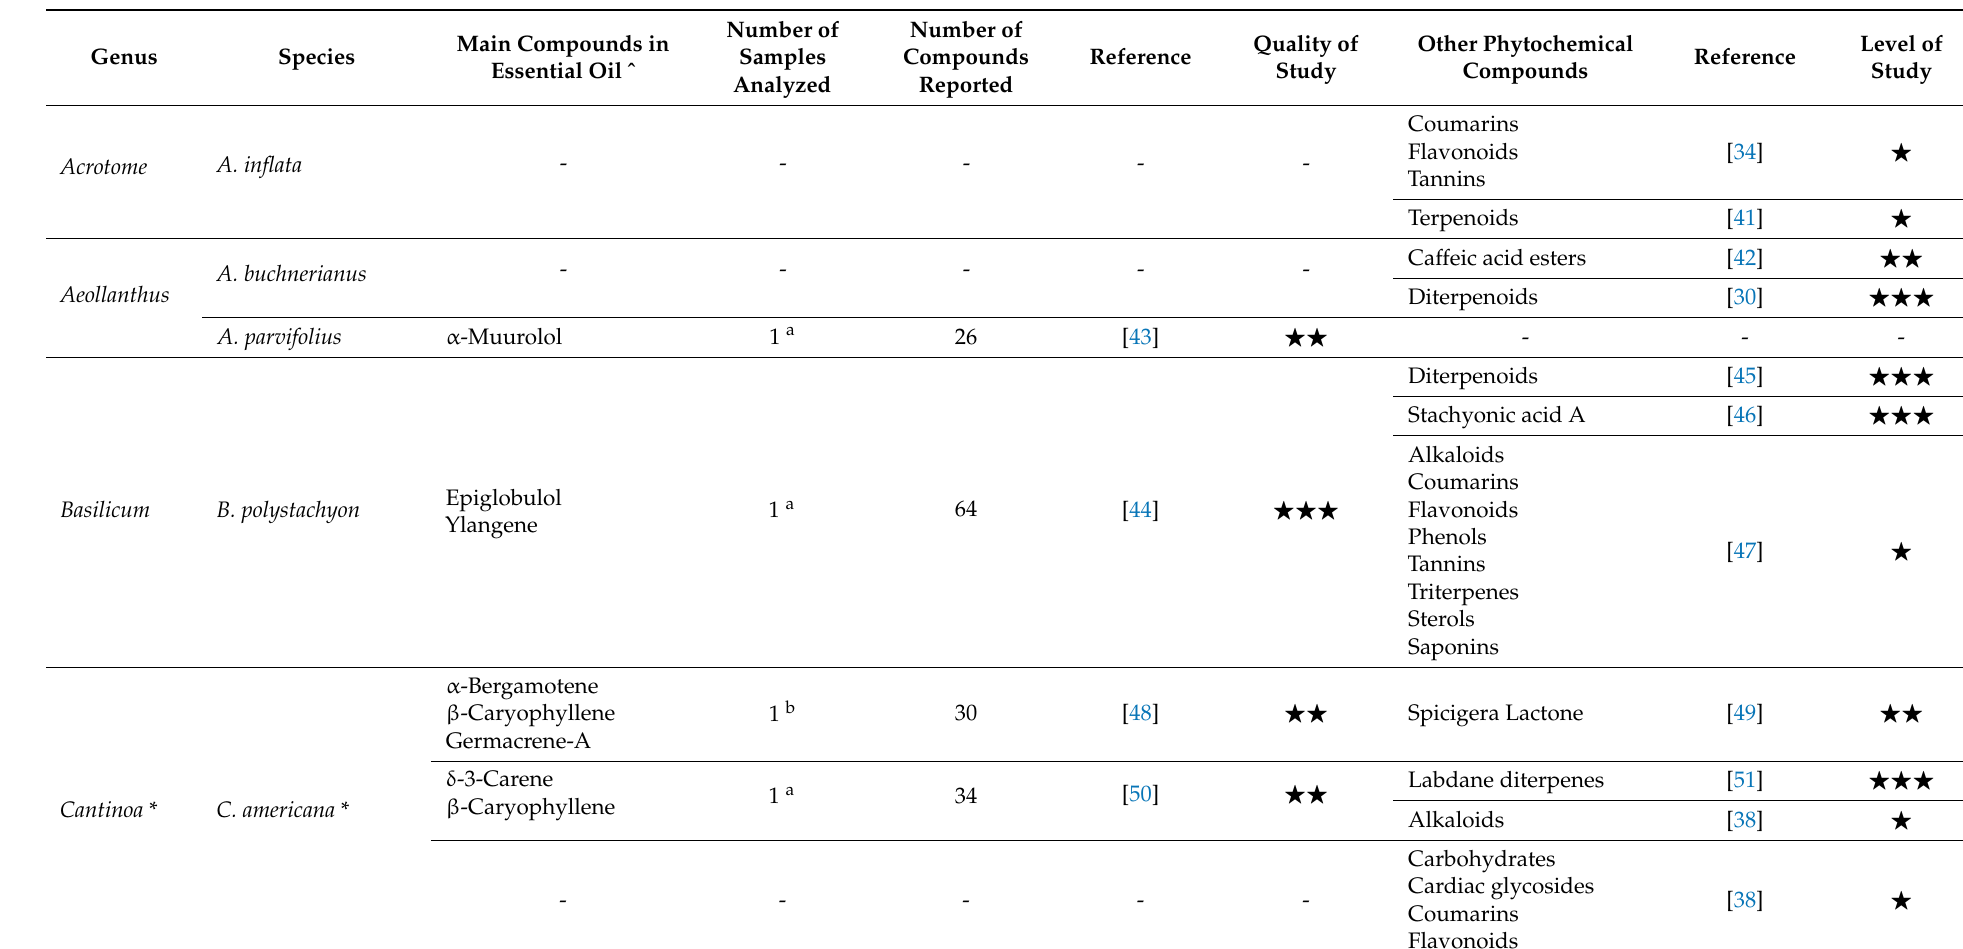
Table 1. Summary of major essential (volatile) oil compounds and phytochemistry data collected for southern African Lamiaceae species. Only the main constituents for essential oils (compounds representing >10% of total yield) and the main classes of compounds for phytochemical studies are